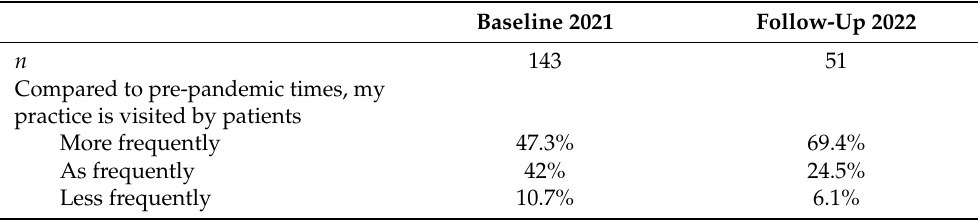
Table 2. Influence of the pandemic on practice workload and differences between the two time